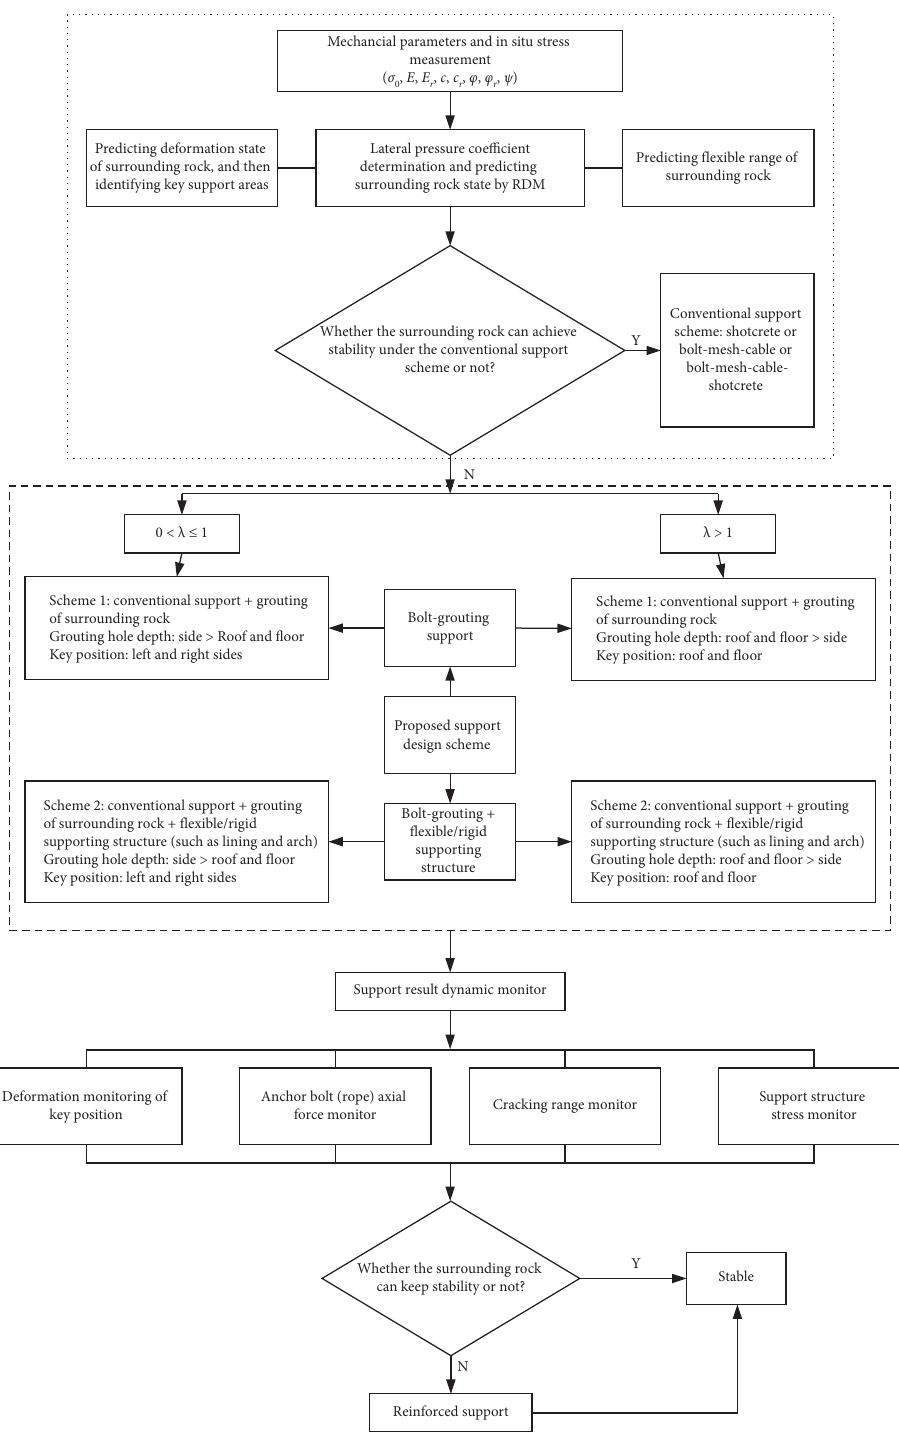
Figure 10: Optimization flow of support scheme of deep circular opening under nonuniform